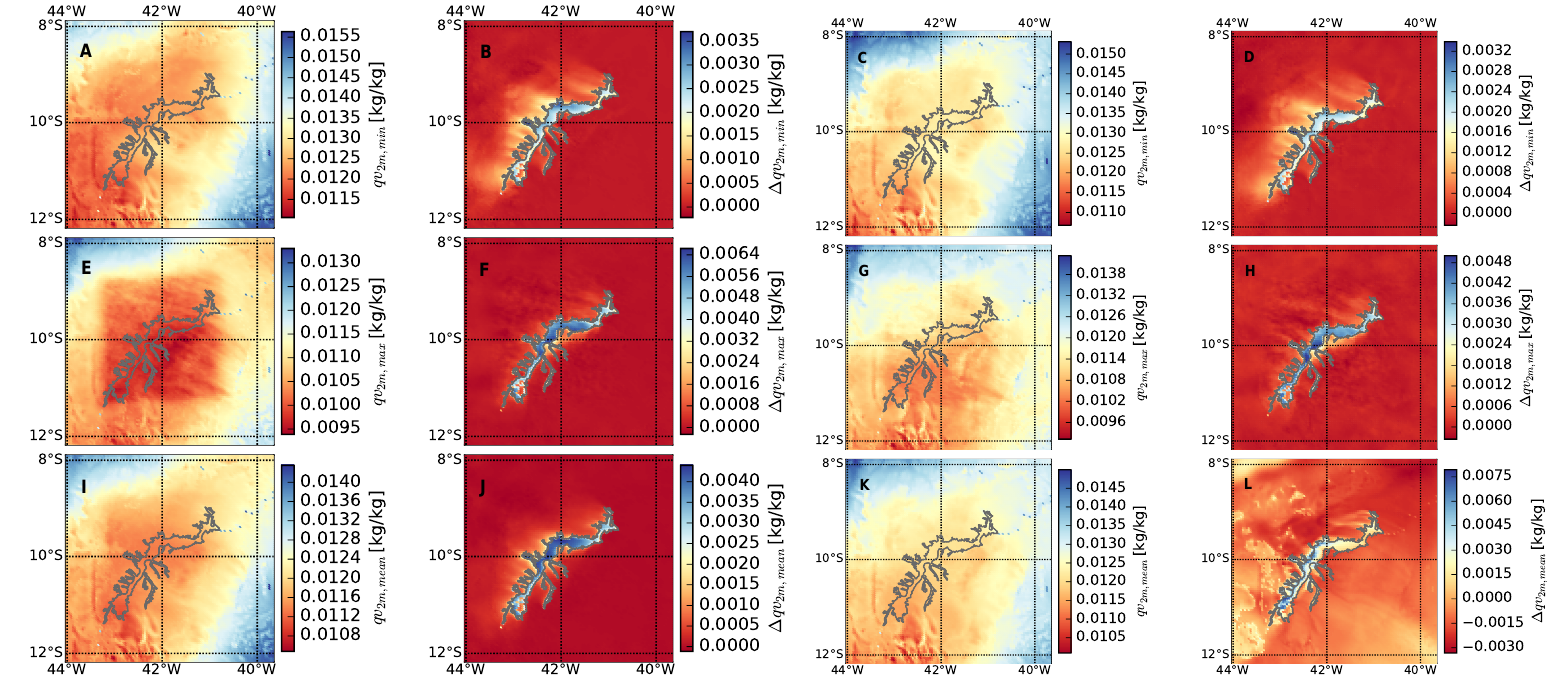
Figure 5. Same as in Figure 4 for specific